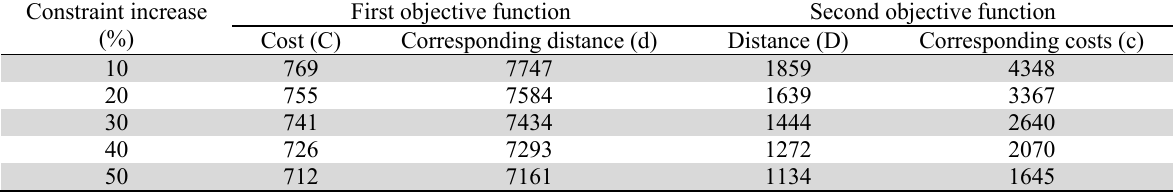
Constraint-based solution results of the two-objective function